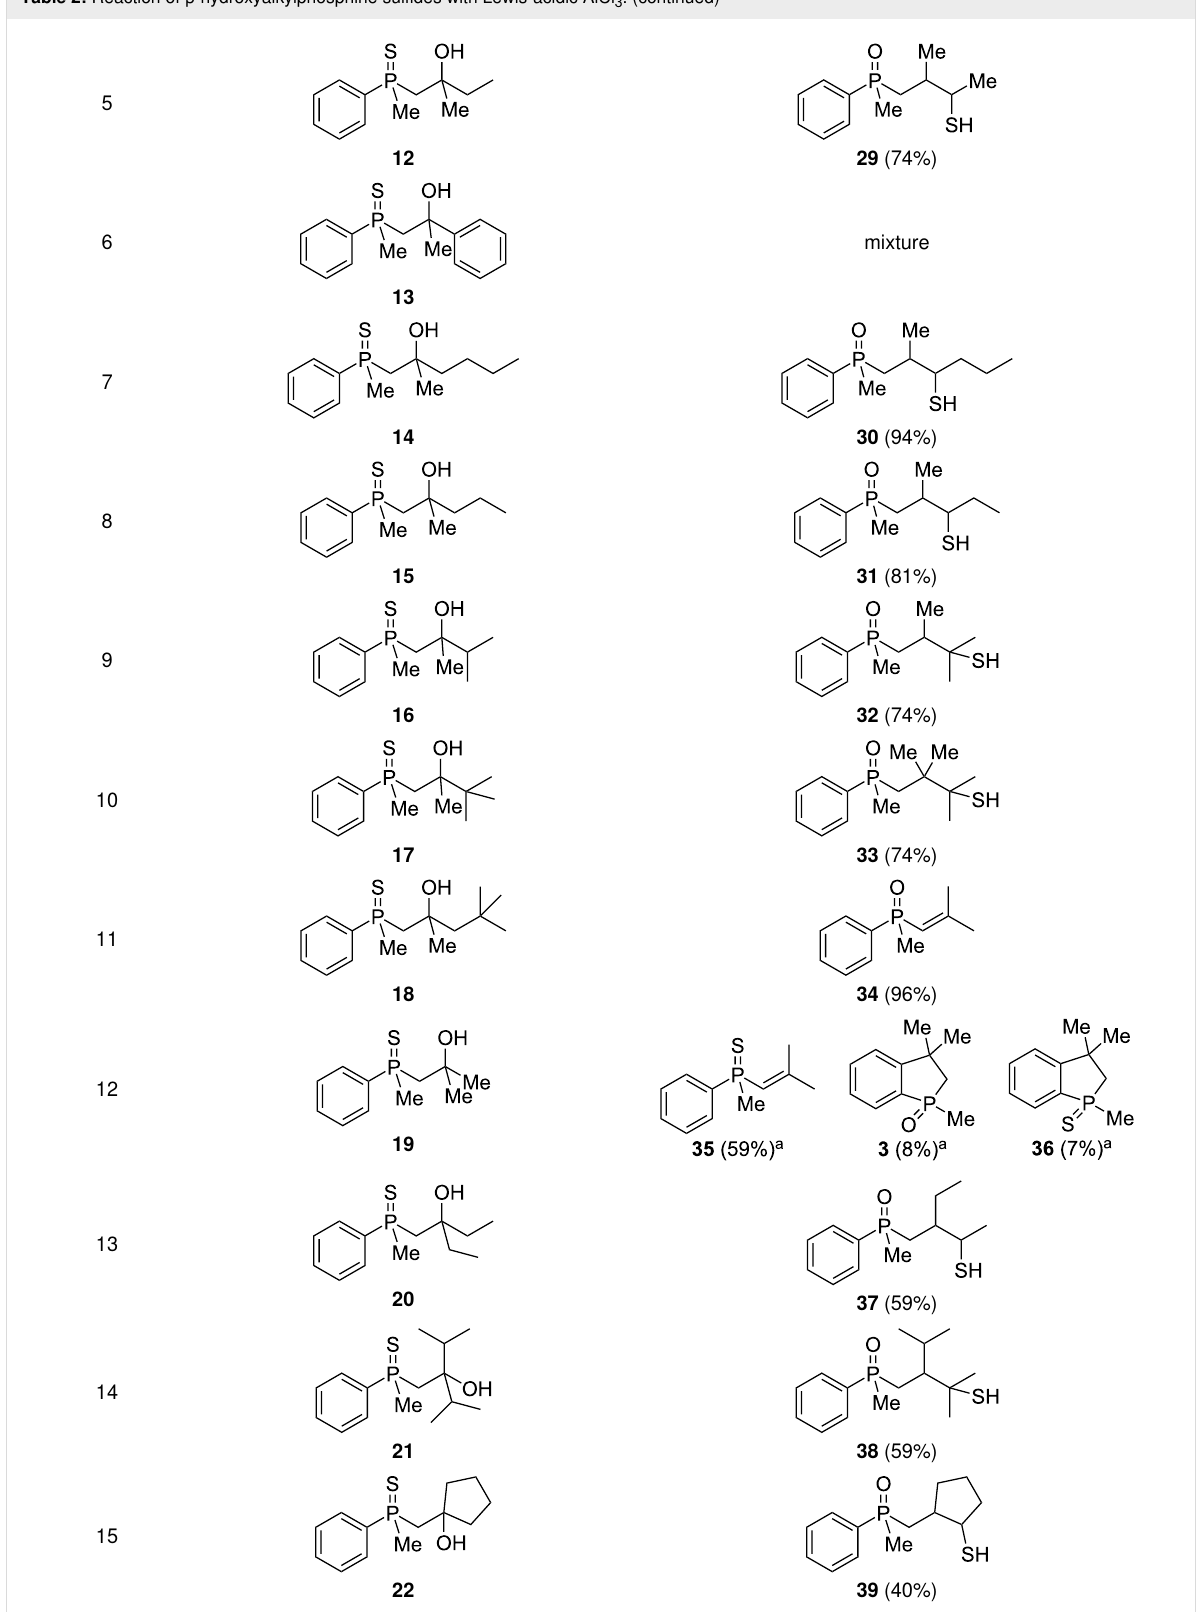
Table 2: Reaction of β -hydroxyalkylphosphine sulfides with Lewis-acidic AlCl 3 .